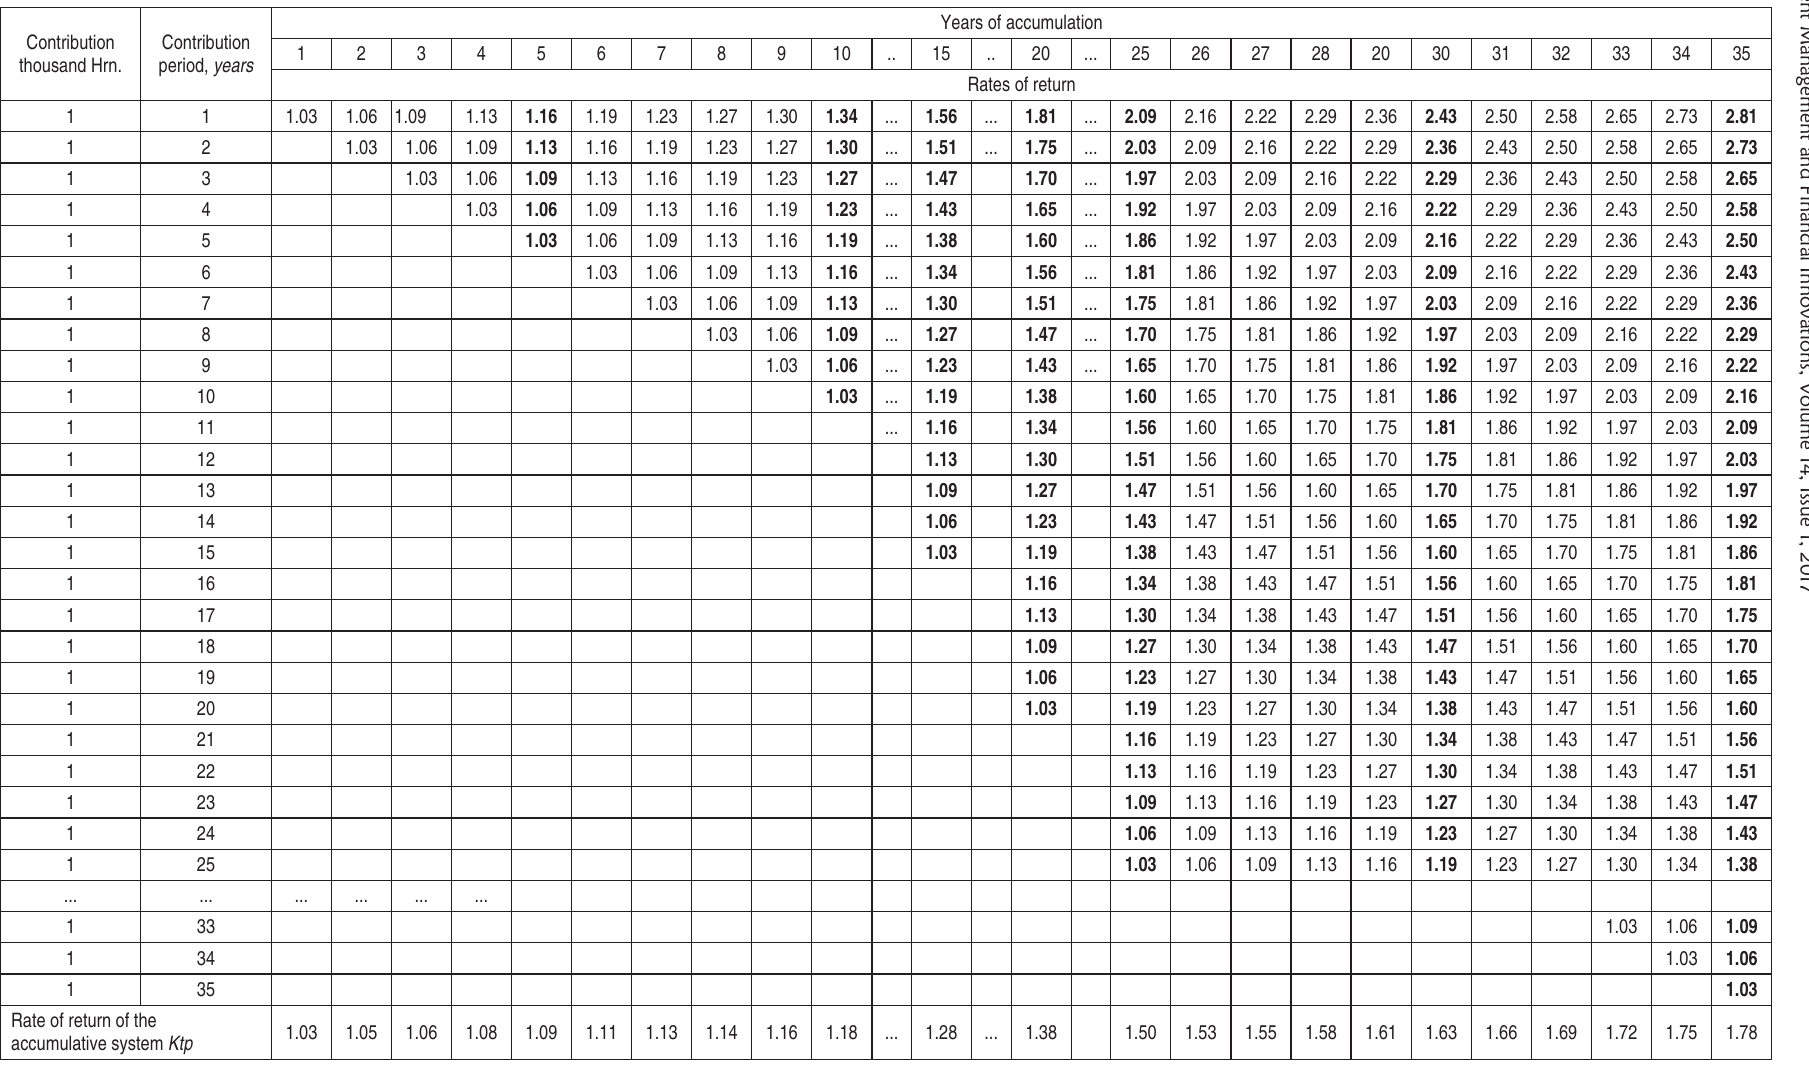
Table 1. Matrix of the rates of return from the funds of the accumulative system